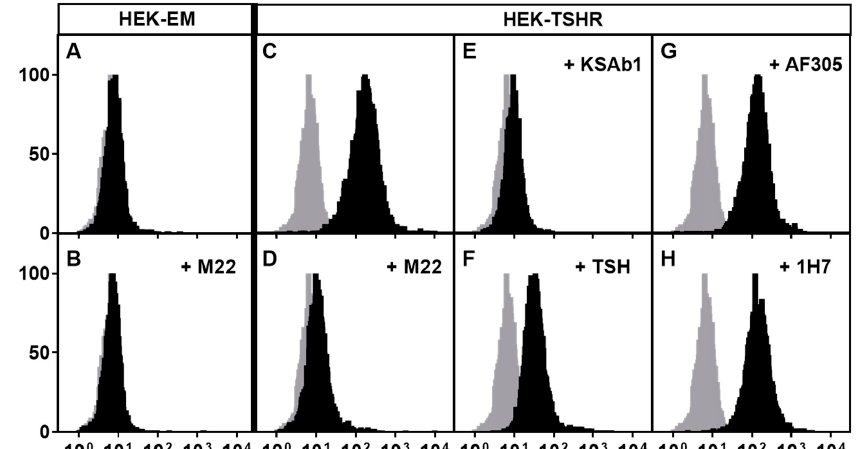
Figure 2. M22 specificity to TSHR demonstrated by competitive binding assay. The human monoclonal antibody M22 was coupled to the fluorescent probe Alexa-647 (Alexa-647-M22), and its binding to cell surface receptors was measured by flow cytometry. Binding of M22-647 was conducted in the presence of excess amounts of unlabeled TSHR agonists (M22, KSAb1, and TSH) and anti-IGF1R antibodies (AF305 and 1H7). Parental HEK293 (HEK-EM) cells do not express TSHRs but endogenously express IGF1Rs, and HEK-TSHR cells overexpress TSHRs and endogenously express IGF1Rs. Gray histograms (all panels) illustrate nonspecific cell autofluorescence. Black histograms (panels C–H) illustrate specific Alexa-647-M22 binding. Panels A and B : In HEK-EM cells, there is no specific binding. Panel C : specific binding that is totally inhibited (panel D ) by an excess of unlabeled M22. Panel E : another unlabeled mouse monoclonal TSHR antibody, KSAb1, completely inhibits specific binding. Panel F : unlabeled TSH partially inhibits specific binding. Panels G and H : unlabeled anti-IGF1R blocking antibodies, AF305 and 1H7, have no e ff ect on specific Alexa-647-M22 binding. Reprinted from